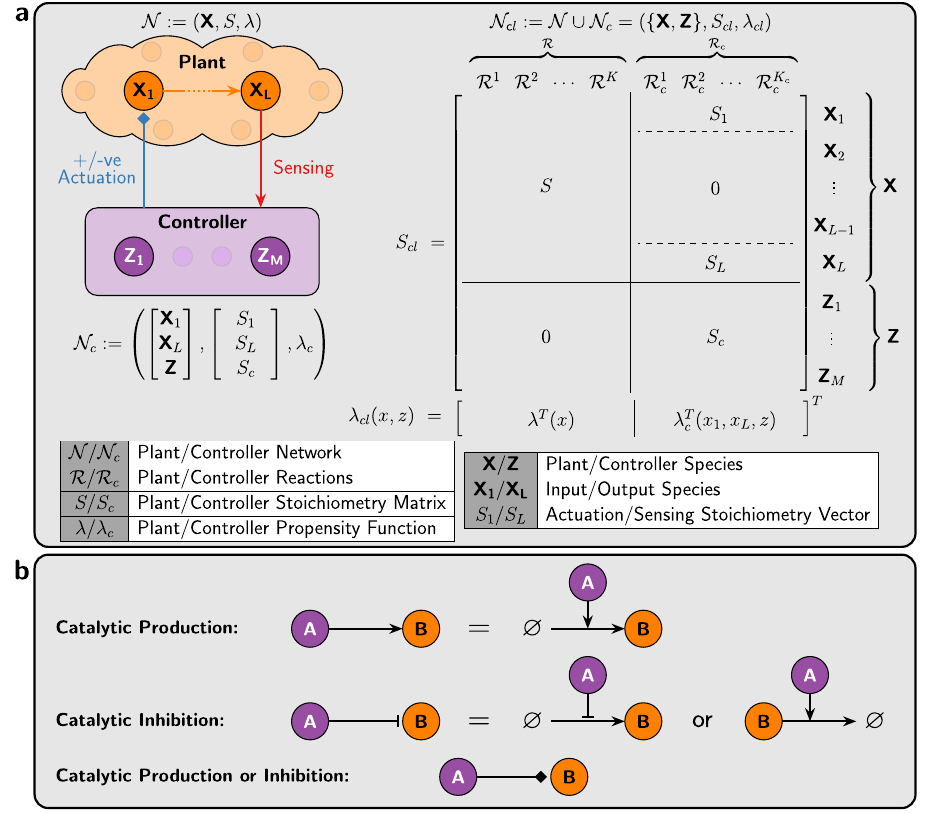
Fig. 2 A framework for feedback control of chemical reaction networks. a An arbitrary plant is comprised of L species { X 1 , ⋯ , X L } reacting with each other. Species X L , by de fi nition, is the output of interest to be controlled, while X 1 is assumed to be the only accessible input species that can be “ actuated" (positively and/or negatively) by the controller network which is comprised of M species { Z 1 , ⋯ , Z M }. The closed-loop system, with stoichiometry matrix S cl and propensity function λ cl , denotes the overall feedback interconnection between the plant and controller networks. The partitioning of S cl and λ cl describes the various components of the closed-loop network. b A description of the compact graphical notation that is adopted throughout the paper. Arrows directed toward species indicate catalytic productions, whereas T-shaped lines indicate catalytic inhibitions that encompass either repressive production or degradation. Note that the propensities of degradation reactions are considered to be either kAB /( B + κ ) if two parameters ( k , κ ) are indicated on the arrow, or η AB if only one parameter η is indicated on the arrow. Finally, diamonds indicate either production or